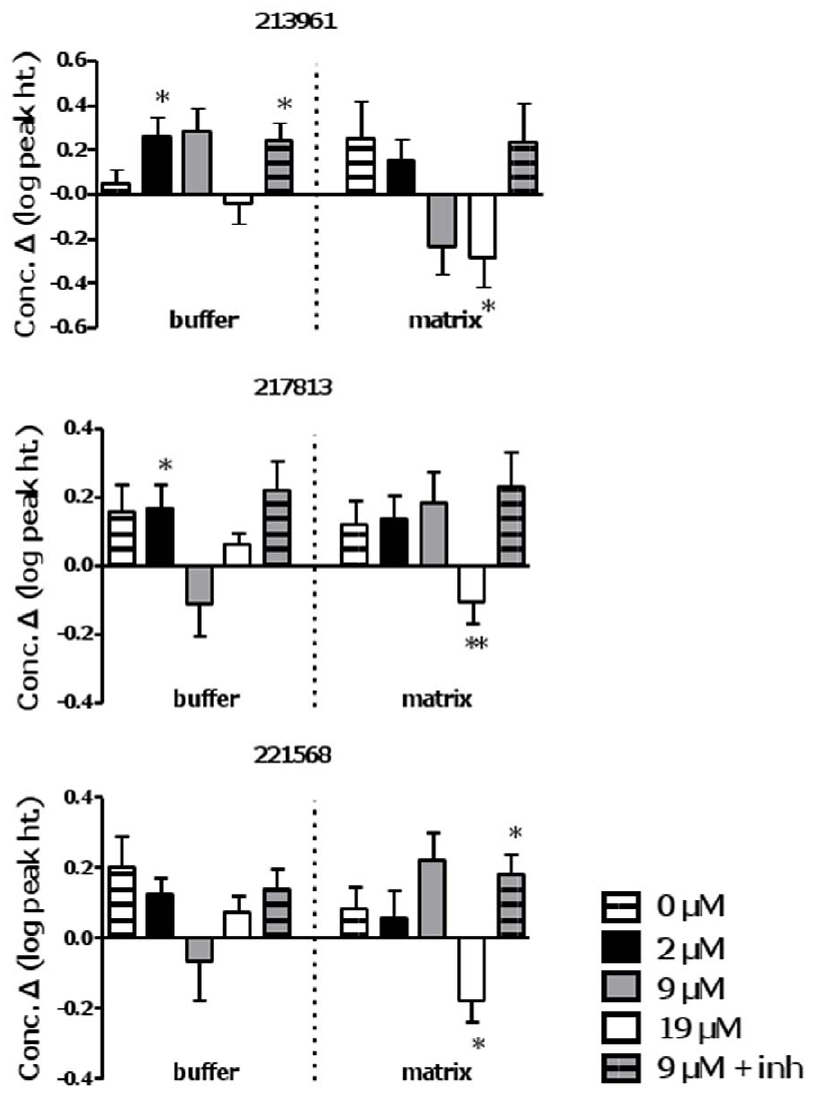
Figure 8. Change over time in levels of selected unidentified metabolites in buffer and matrix fractions obtained from muscle mitochondrial preparations. Significance: paired t-test, 0 vs . 20 min, within treatment; * P , 0.05; **, P , 0.02. See legend to Figure 5 for further details.